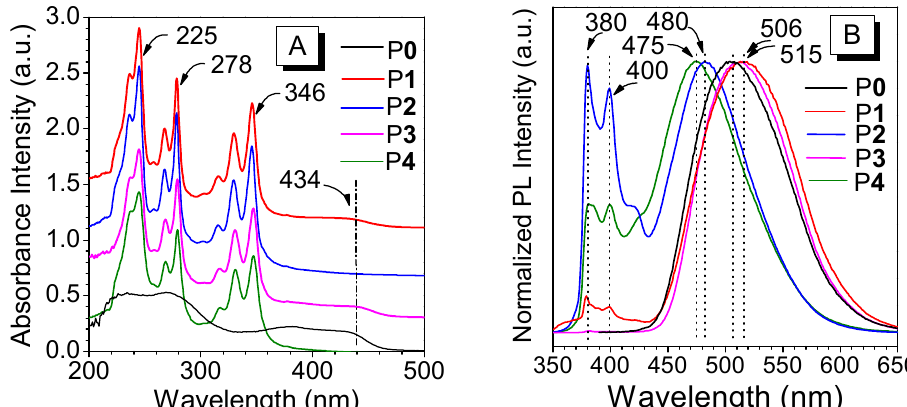
Figure 5. UV–Visible absorption ( A ) and normalized photoluminescence (PL) spectra ( B ) of the precursor polymer (P 0 ) and the derived pyrene-functionalized Polyacetylenes (P 1 –P 4 ). Solvent: THF, concentration: 0.02 mmol / L, λ ex = 343 nm.